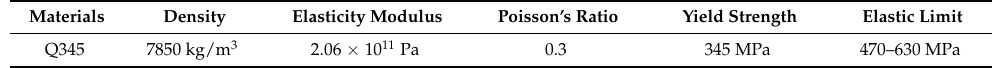
Table 1. Material properties of Q345.